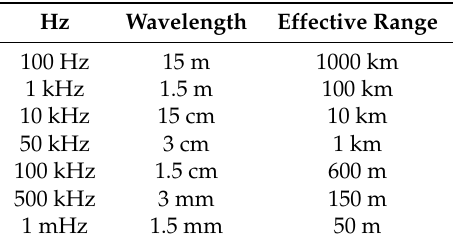
Table 1. Two-way working range in SONAR